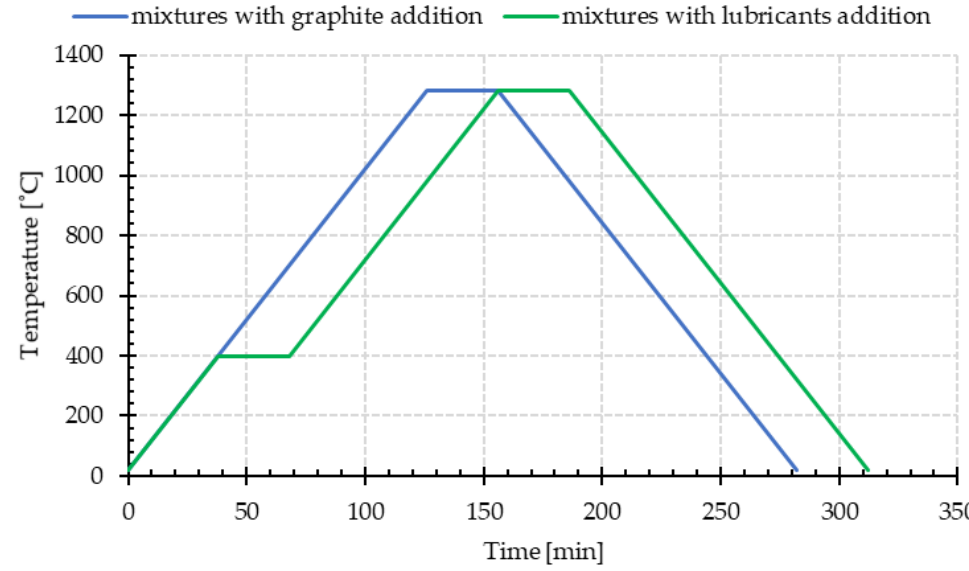
Figure 1. The temperature profiles of the sintering process for the tested mixtures.